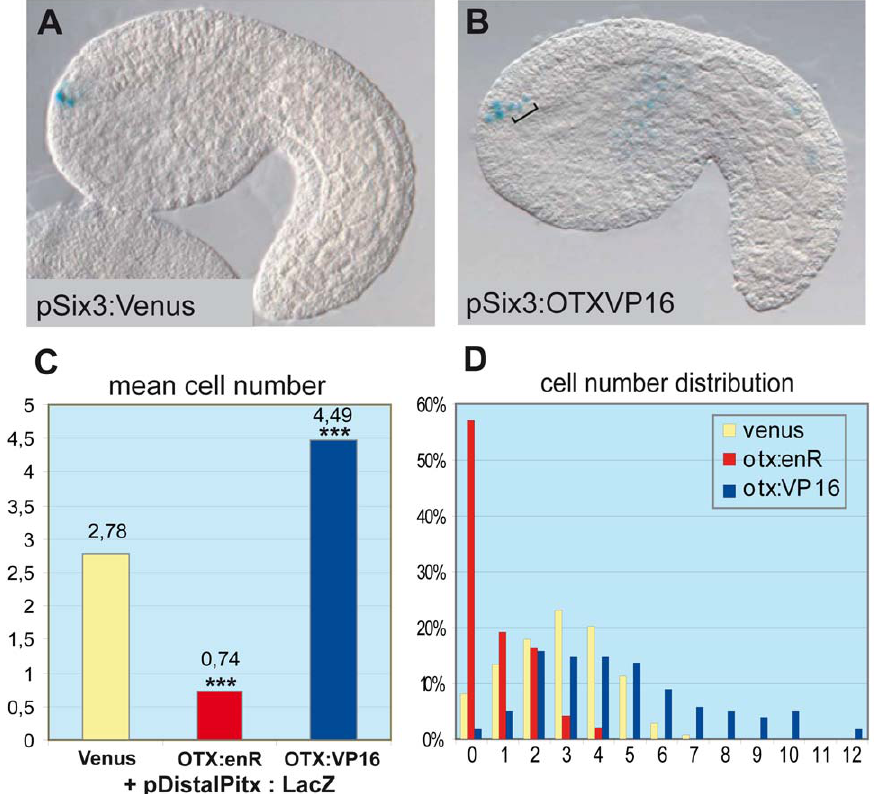
Figure 3. OTX fusions influence the activity of the Ci-pitxcis -regulatory element. Co-electroporation of Pitx full length distal region (pDistal Pitx :lacZ, 5.3kb, containing D1), respectively with pSix3:Venus (control), with pSix3 . OTX HD ::enR (dominant negative OTX) and pSix3 . OTX HD ::VP16 (hyper-active OTX). (A) Side view of an embryo co-electroporated with pDistal Pitx :lacZ and pSix3:Venus. Three positive cells can be detected in the ANB. (B) Co-electroporation of pDistal Pitx :lacZ and pSix3 . OTX HD ::VP16. In addition to the expression in the ANB, ectopic